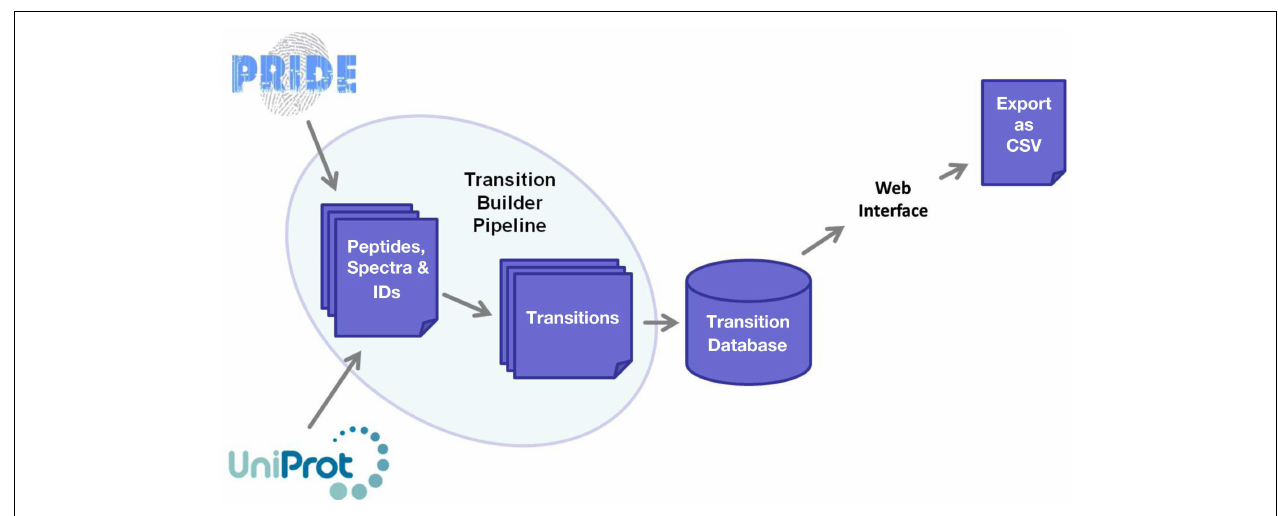
transition database is populated by MRMaid’s transition builder pipeline, which takes SwissProt protein sequences from UniProt and mines spectral data in PRIDE to identify the best transitions for each